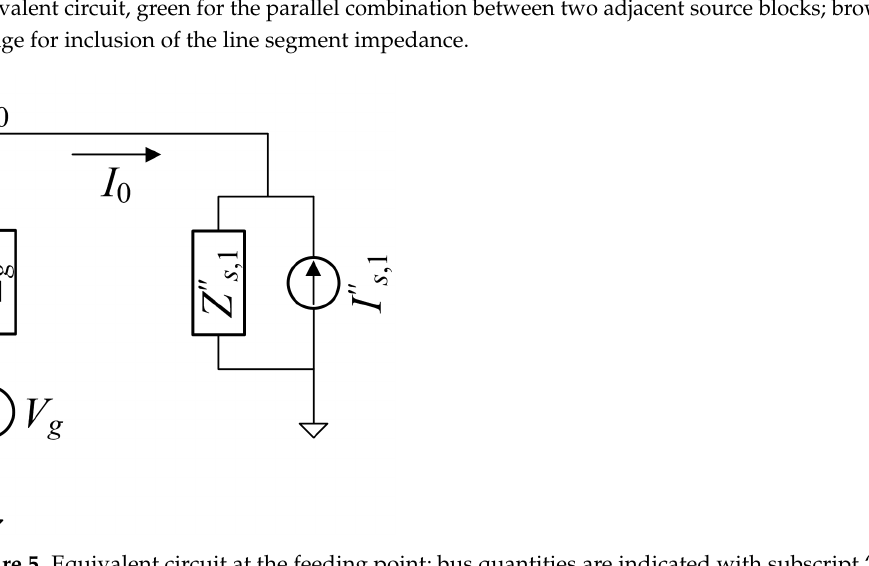
Figure 5. Equivalent circuit at the feeding point; bus quantities are indicated with subscript